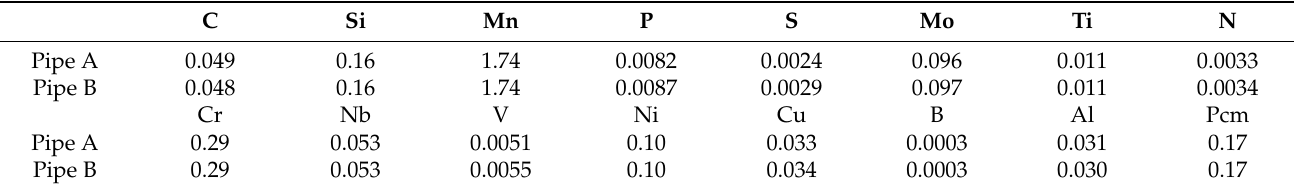
Table 2. Chemical compositions of Pipe A and Pipe B (Wt × 10 − 2